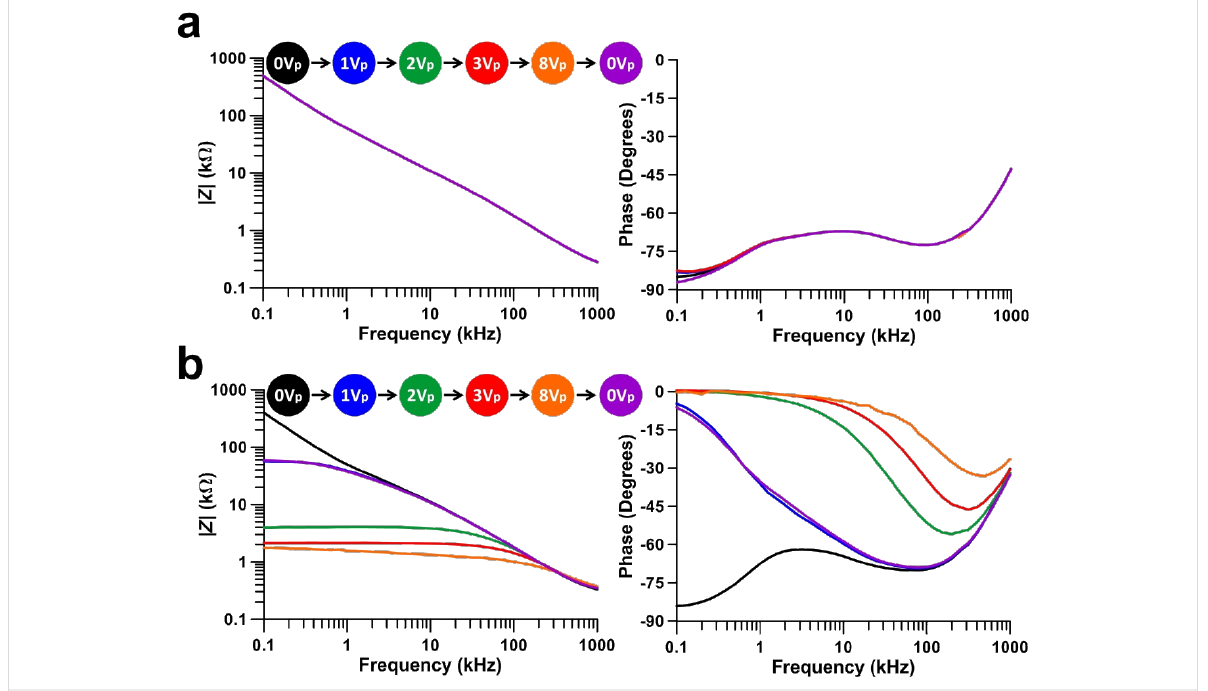
Figure 7: Impedance magnitude and phase measurements of (a) undoped and (b) SWCNT-doped LC cells.